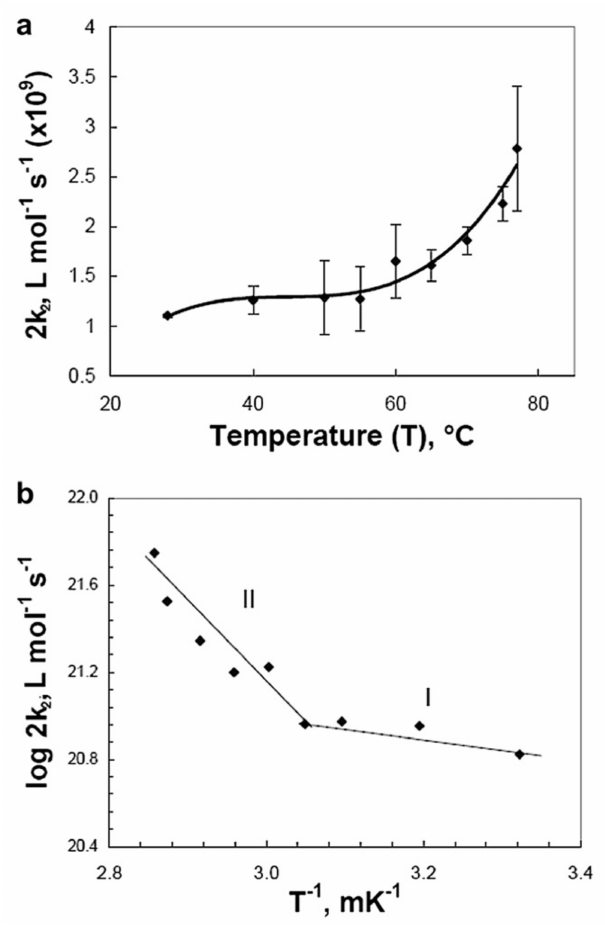
Figure 11. ( a ) Second-order reaction (decay) rate constant (2 k 2 ) as a function of temperature; ( b ) Ar- rhenius plot of 2k 2 from which average activation energies E a = (4.2 ± 1.7) kJ mol − 1 (I) and (28.5 ± 7.9) kJ mol − 1 (II) were derived for two different temperature regions in N 2 O-saturated PVP aqueous solutions (2.54 × 10 − 6 mol L − 1 PVP, M w = (3.94 ± 0.12) × 10 5 g mol − 1 ). Adapted with permission from [22]; published by Elsevier,